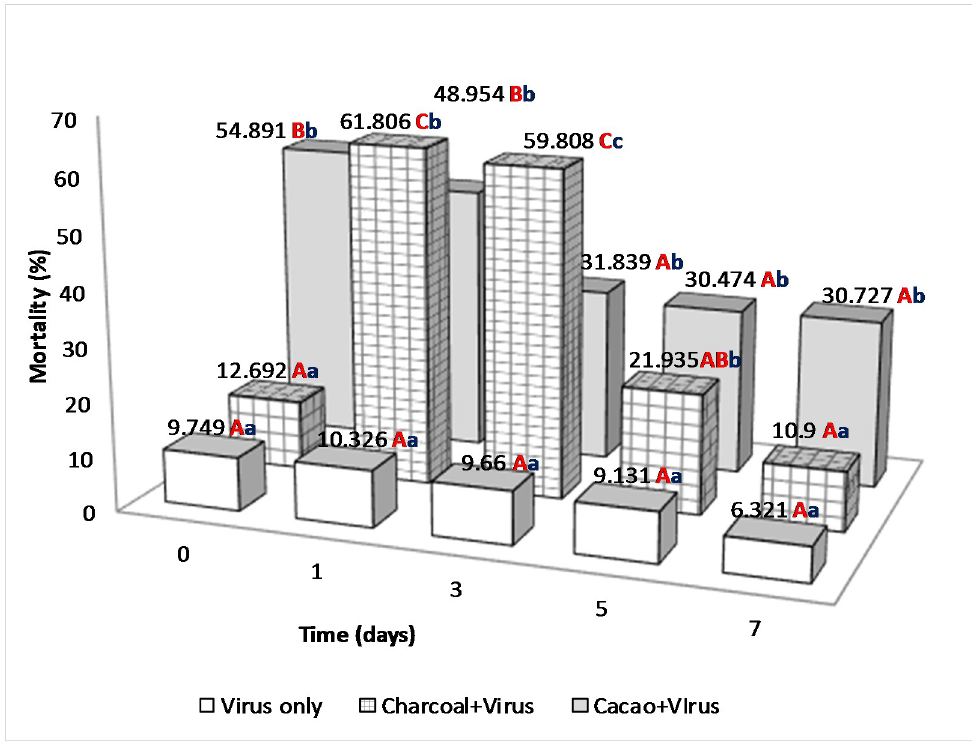
Fig 4. Percentage of mortality of 2nd instar larvae of C . chalcites at 0, 1, 3, 5 and 7 days post application (2018). Treatments: (i) Charcoal 1% + ChchNPV-TF1, (ii) Cacao 1% + ChchNPV-TF1, (iii) Control (water + ChchNPV-TF1). � Capital letters represents differences among the treatments, lower case letters represent differences among the days post